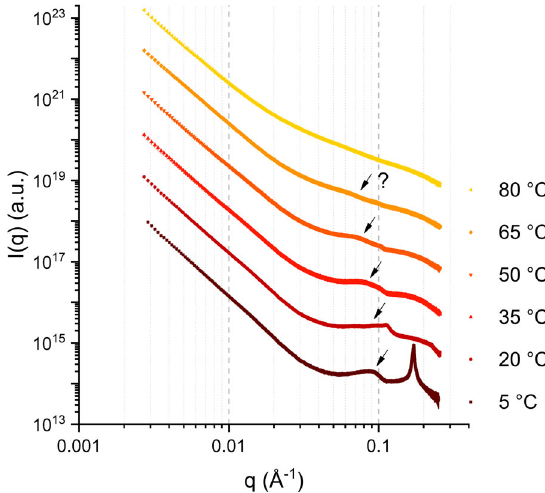
Fig. 2 Example of SAXS curves. SAXS curves obtained for the sample C10 mix + 2% squalane at p = 1 bar. The errors are calculated by propagating the errors of the 30 averaged frames (which come from Poisson distribution). Most of the error bars are smaller than the symbol size. All curves were vertically shifted for